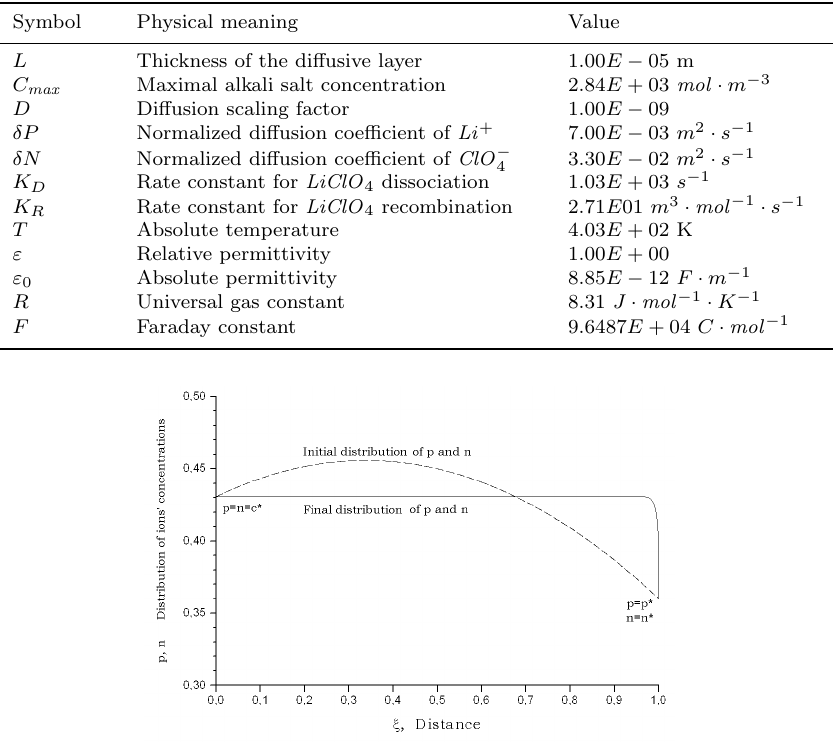
case of p ∗ = n ∗ with p ∗ (cid:54) = c ∗ and n ∗ (cid:54) = c ∗ the bulk is also electroneutral, but its state differs from the equilibrium of the diffusive layer. As a result, by the moment of τ = 10 − 4 we get the final distribution of p and n with a boundary layer at ξ = 1 (see Fig.